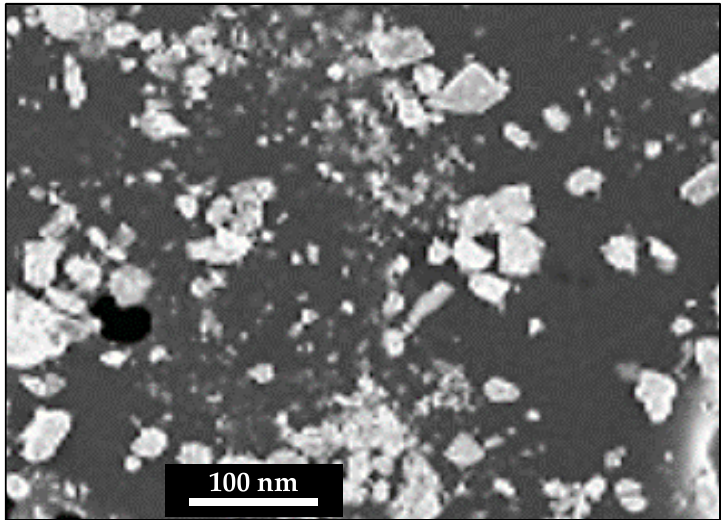
Figure 1. FE-SEM image for the as received TiC nanoparticles.